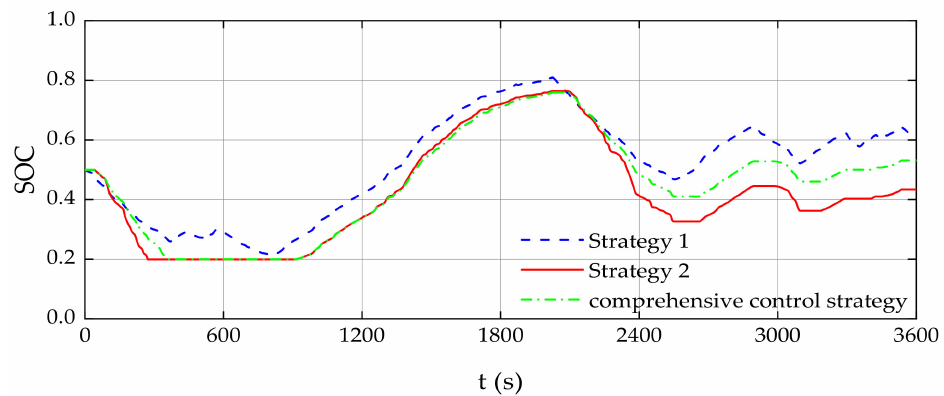
Figure 16. SOC change curve of BES system under 60 min continuous load